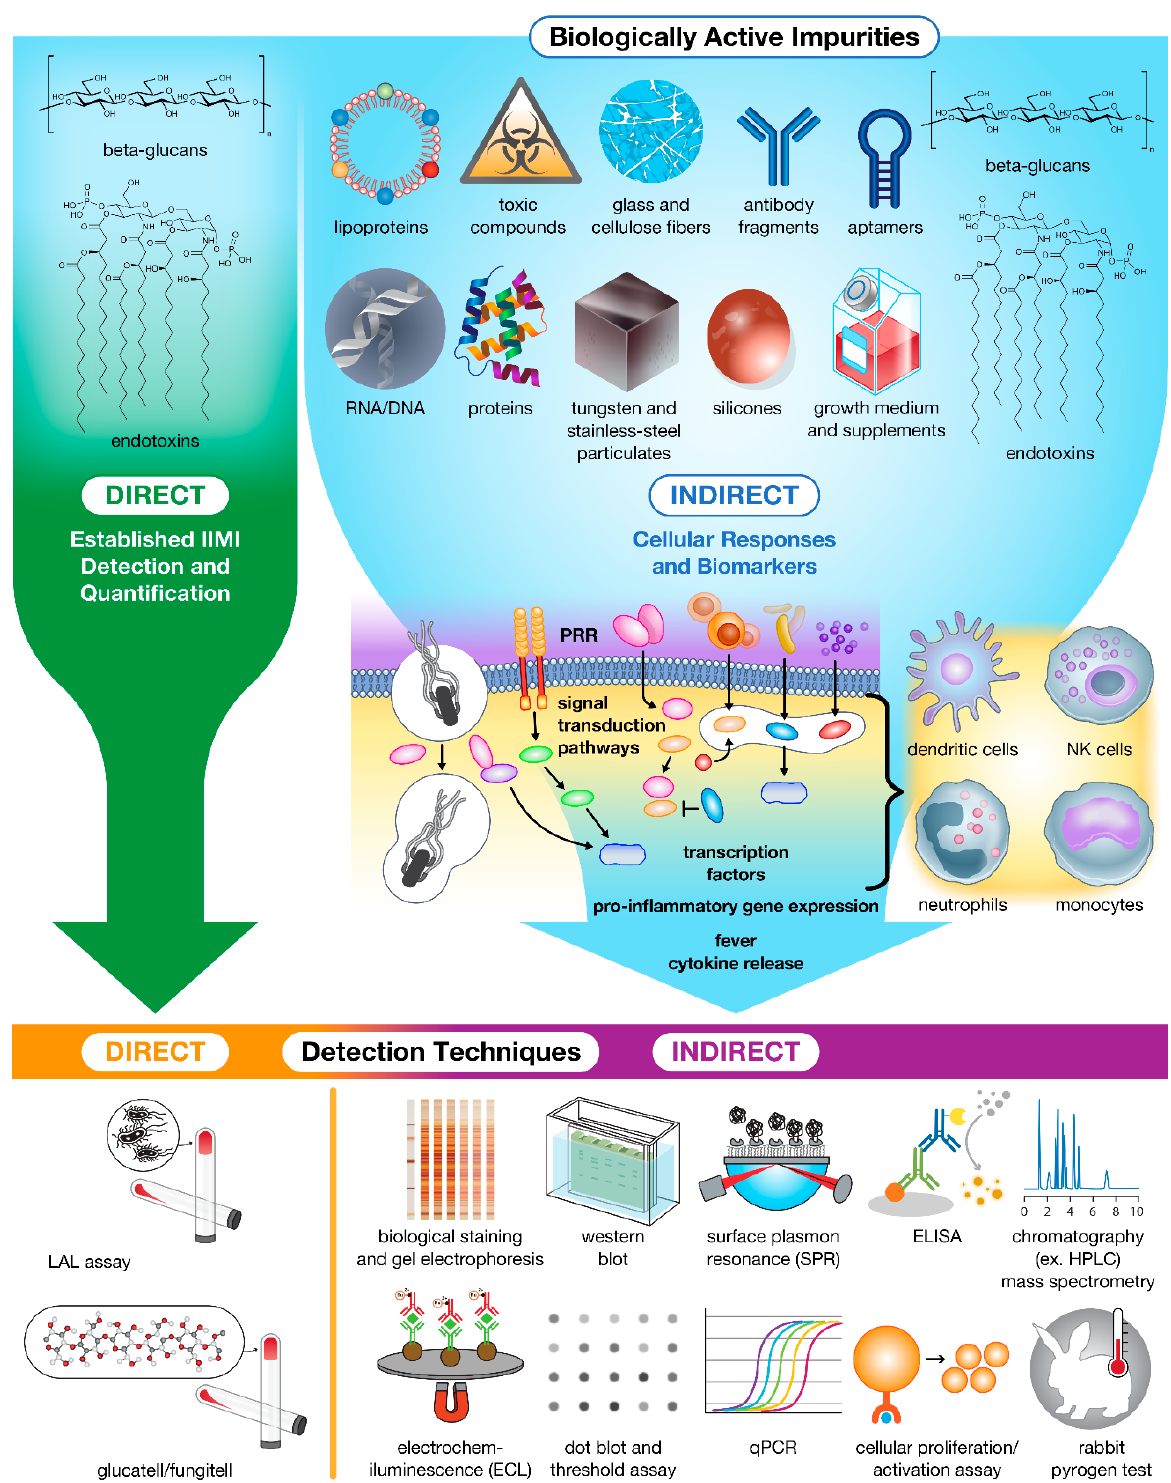
Figure 2. Impurities in drug products trigger innate cellular responses and produce biomarkers for bioassay detection and Quantification. Currently, only β -glucans and endotoxins can be detected and quantified directly using specialized assays. The remaining population of impurities must instead be detected and quantified indirectly using downstream biomarkers (e.g., proteins, peptides, and nucleic acids) and immune cell activation as hallmarks of